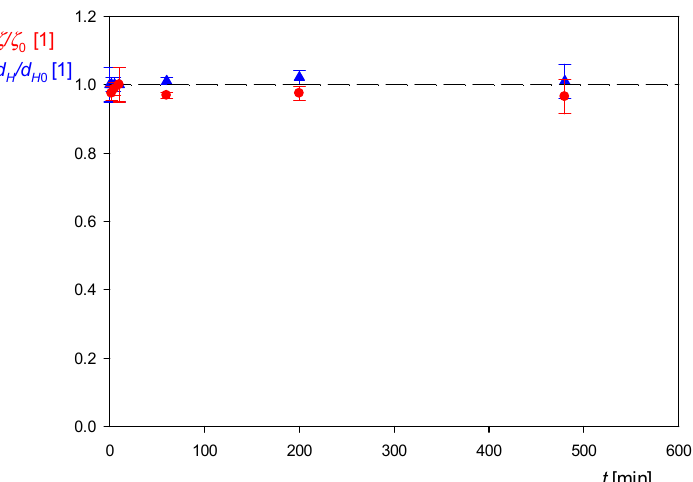
Figure 6. Stability of the polymer particles with the myoglobin corona of the coverage 0.87 mg m − 2 expressed as the dependence of the normalized zeta potential ζ / ζ 0 ( (cid:78) ), and the normalized hydro- dynamic diameter d H /d H 0 ( • ) on the storage time (where ζ 0 and d H 0 are the zeta potential and the hydrodynamic diameter for the initial time); pH 3.5 and 0.01 M, NaCl.